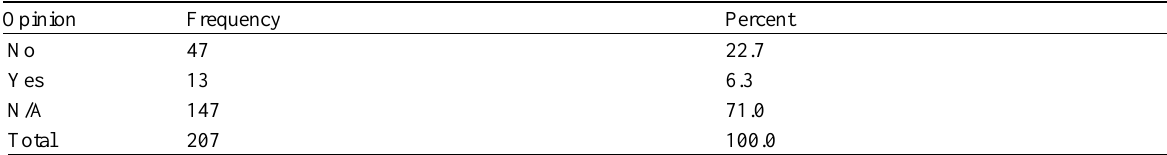
Table 13: Community is involved in Preparation of M&E